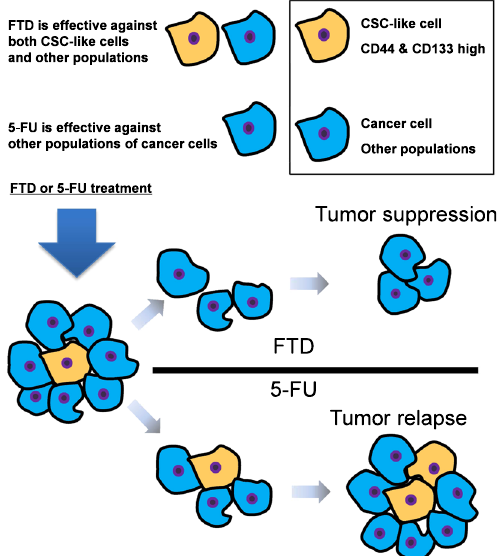
Figure 5. Schematic view of the efficacy of FTD treatment on CD44 + CD133 + cells. FTD is effective against cancer stem cell (CSC)-like (CD44 + CD133 + ) cells, but CSC-like cells show resistance toward 5-FU. FTD